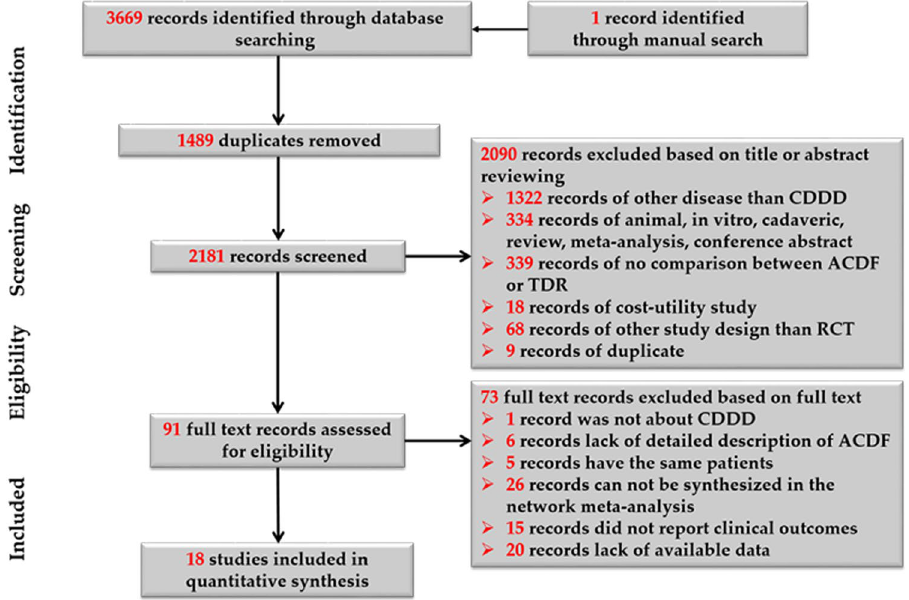
Figure 1. Flow chart of studies included in the